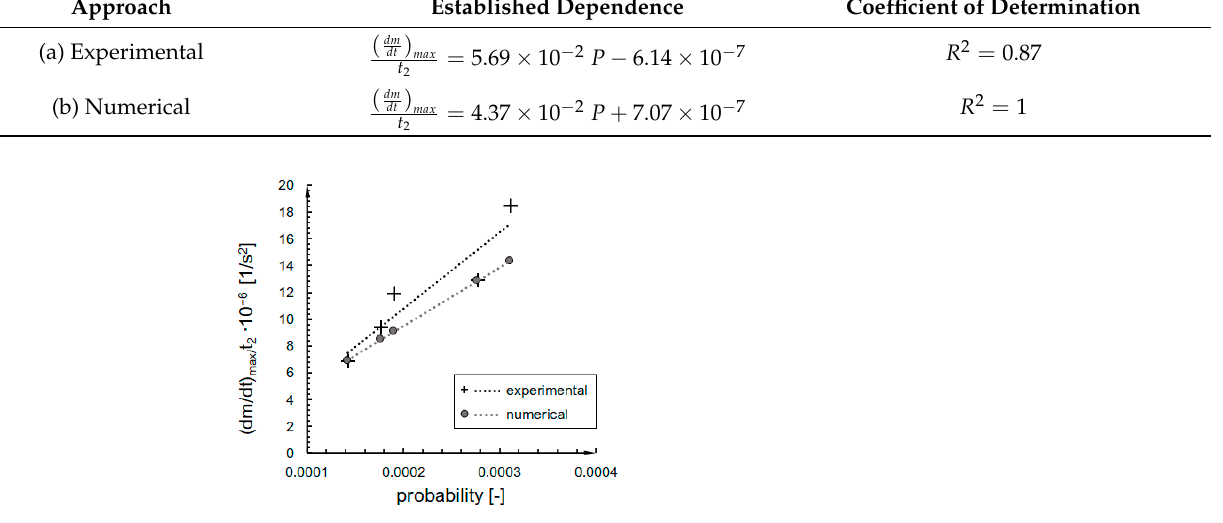
(cid:16) (cid:17) dm / t 2 ratio on probability of an effective collision for (a) experimental, dt max